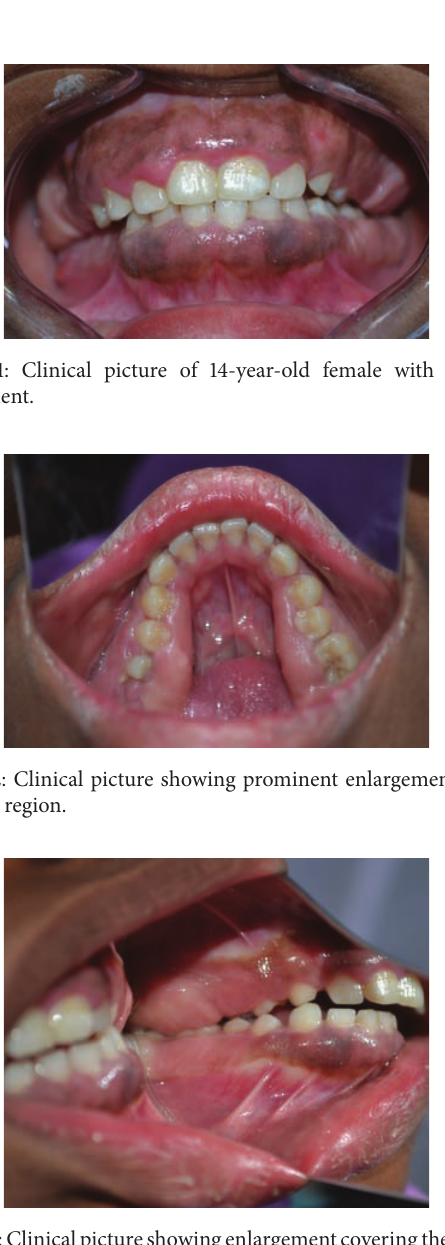
Figure3:Clinicalpictureshowingenlargementcoveringthecrowns of molars.